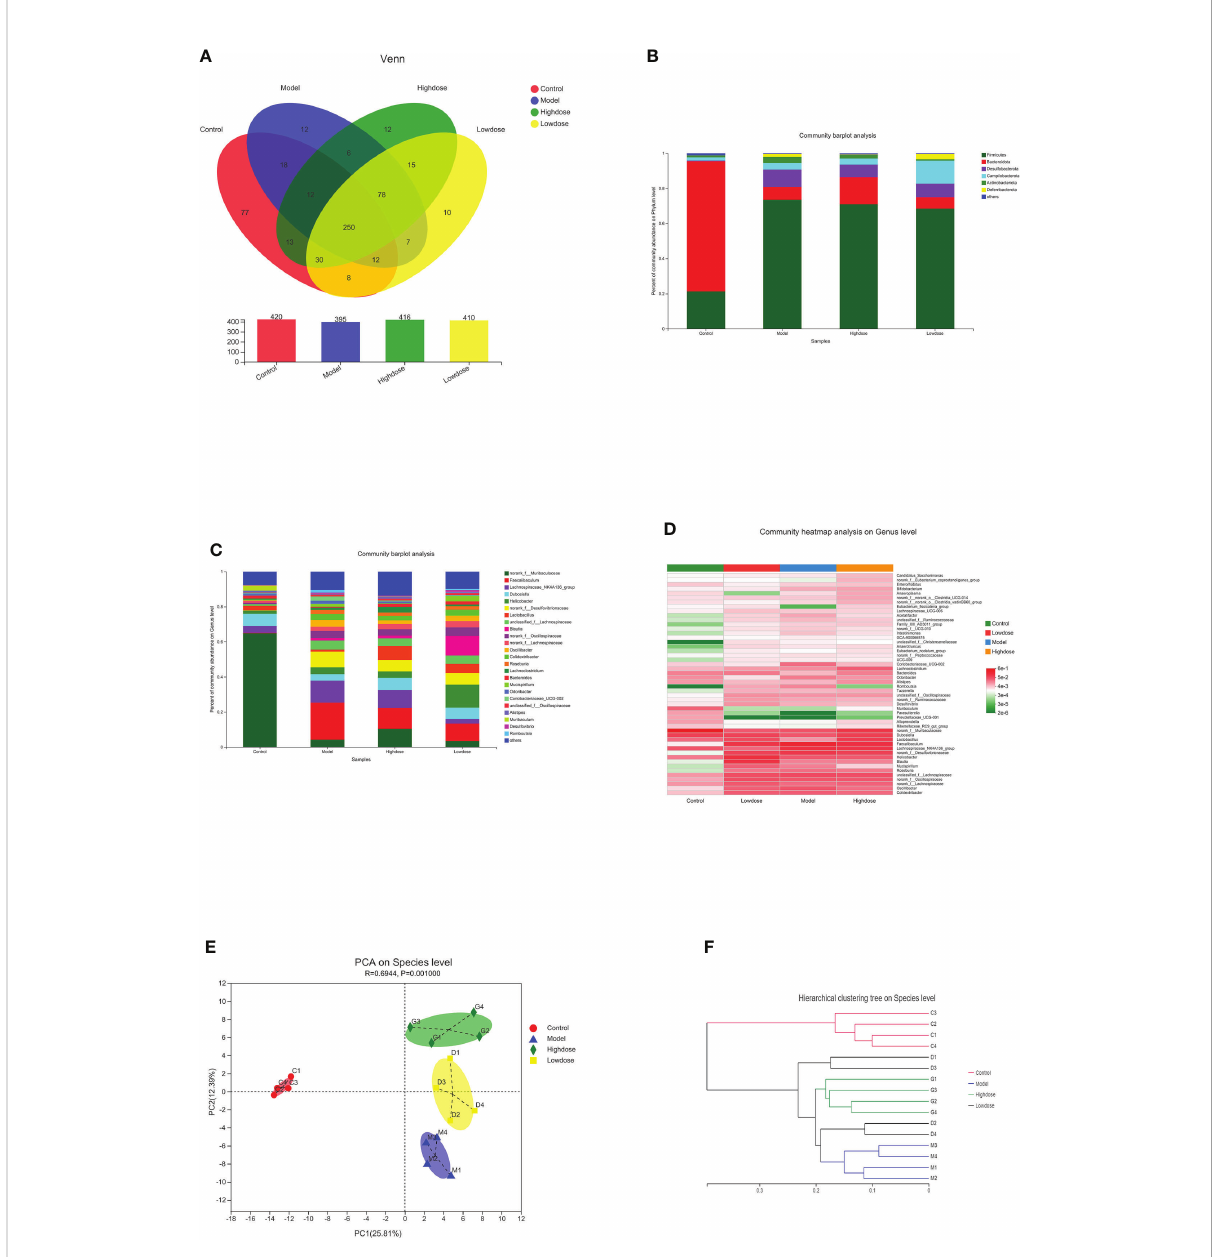
FIGURE 5 Composition of gut microbiota. (A) Venn diagram. (B) Community barplot analysis on phylum levels. (C) Community barplot analysis on genus levels. (D) Cluster heatmap of species richness at the genus level. (E) PCA on species level. (F) Hierarchical clustering tree on species